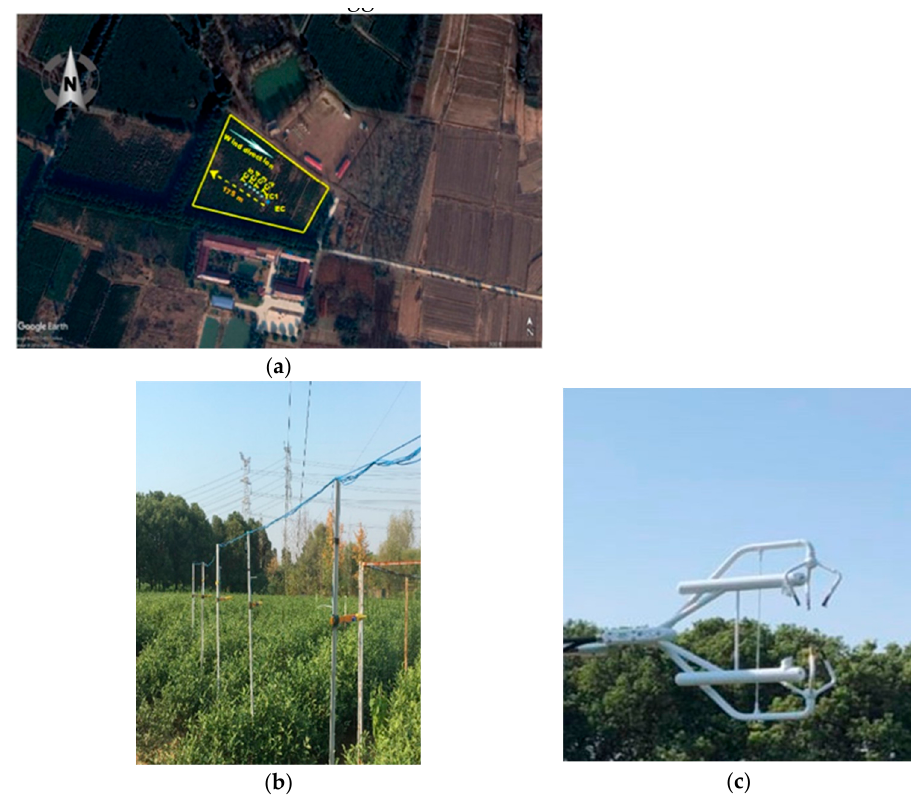
Figure 2. The experimental setup ( a ) Schematic top view of the tea field with thermocouples positions (TC 1 ... TC 5 ) and EC system (Pic from google earth). ( b ) Photo of the TC sensors distributed in the tea field along the prevailing wind direction. ( c ) The EC system (Campbell Scientific, USA).